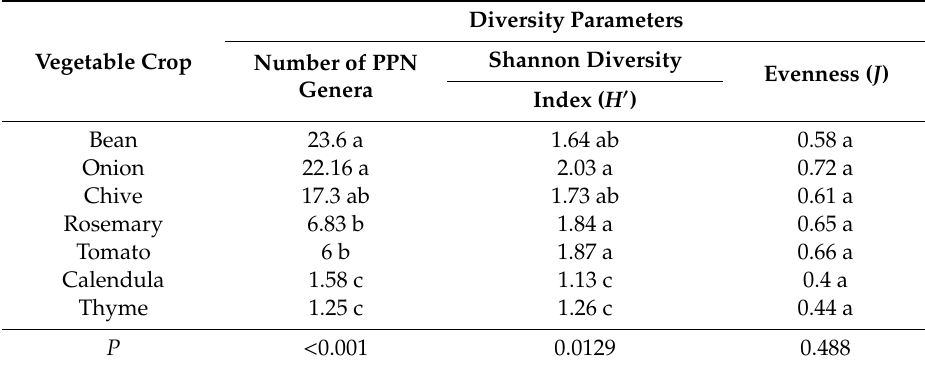
Figure 5. Plant parasitic nematode taxon dominance patterns and their spatial population dynamics. ( A ) Distribution diagram (Abundance-Frequency) of nematode communities. The green line represents the linear regression obtained between calculated parameters. Dotted lines represent confidence intervals at a 95% probability rate. ( B ) Bubble-PCA spatial plot of main PPN populations associated with organic crops. Bubbles represent predicted spatial densities with various ranges. Nematode genera codes are given in Table 1. Table 5. Shannon–Weaver diversity ( H ′ ), evenness ( J ), and the number of nematode genera in each of the six surveyed crops.